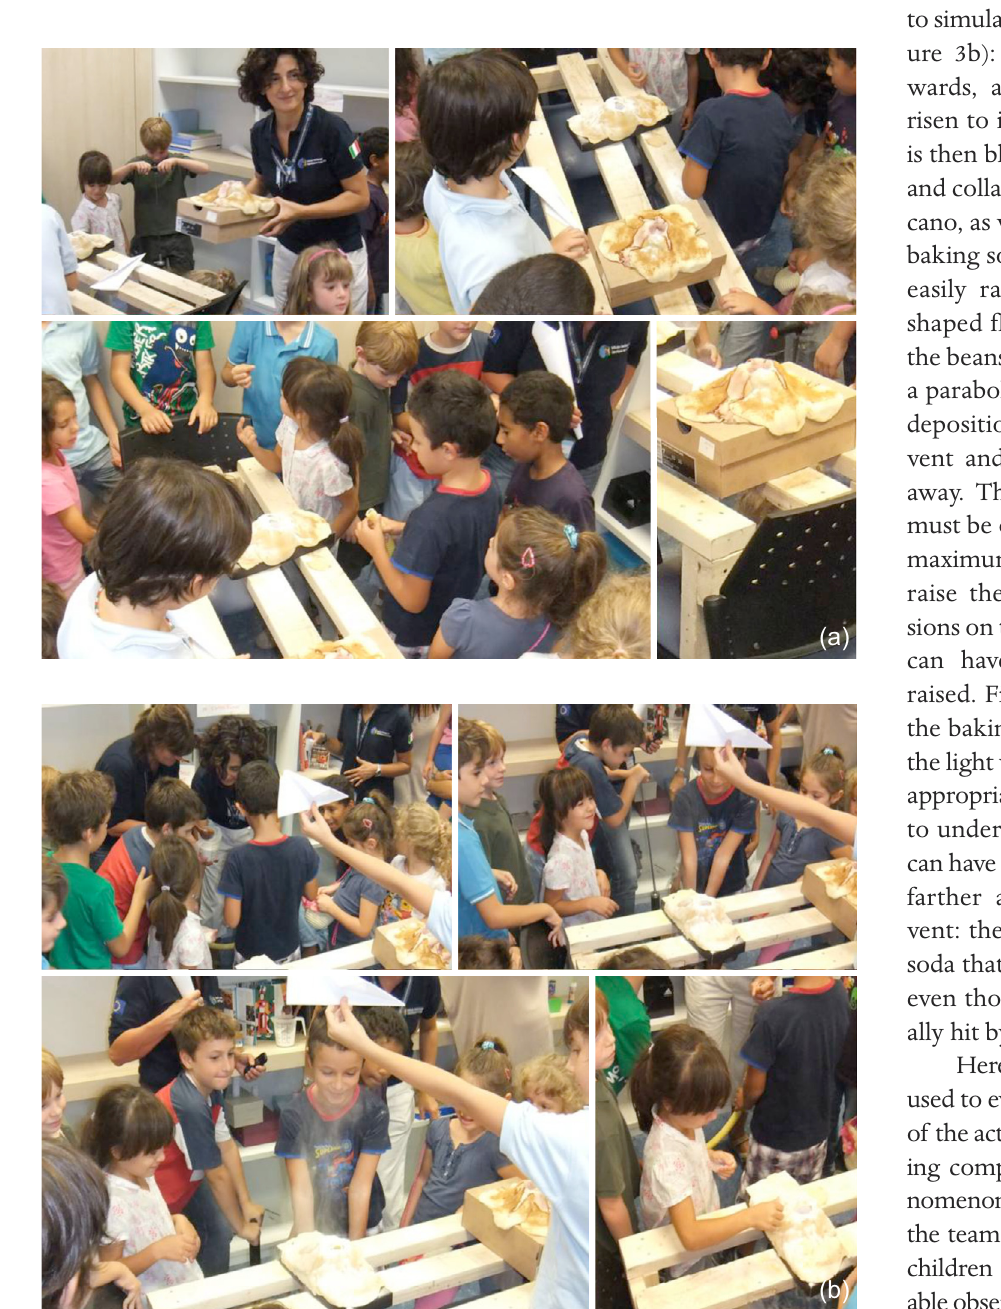
Figure 3. Laboratory activities of “Scientists as a game”: Shield and strata volcanoes . (a) Lava flow eruption from a shield volcano model. (b) Baking soda powder is pumped out of a volcano vent to simulate pyroclastic flow. The children are holding a paper airplane that is positioned at a flight height that is scaled to the height of the